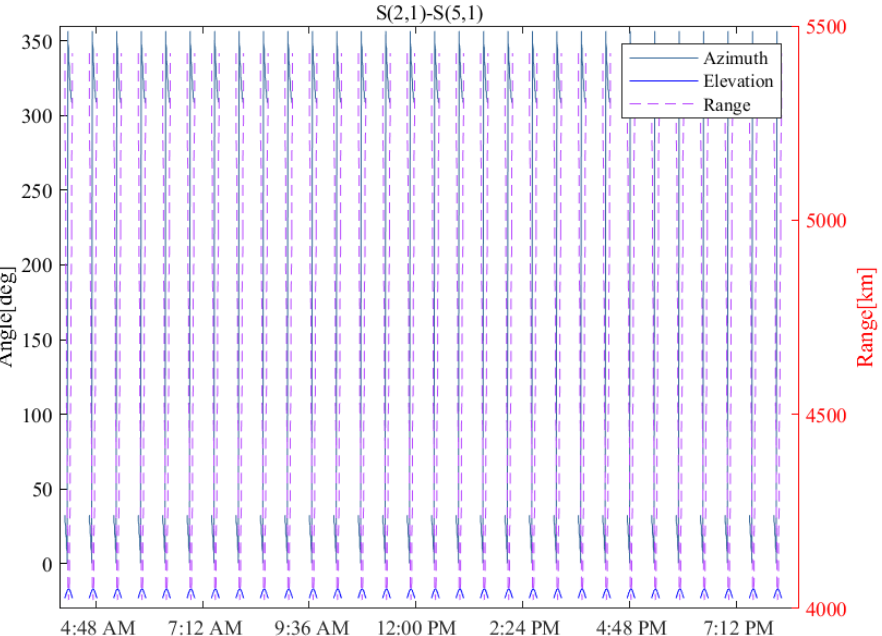
Figure 15. Neighboring non-adjacent orbital link AER characterization diagram.